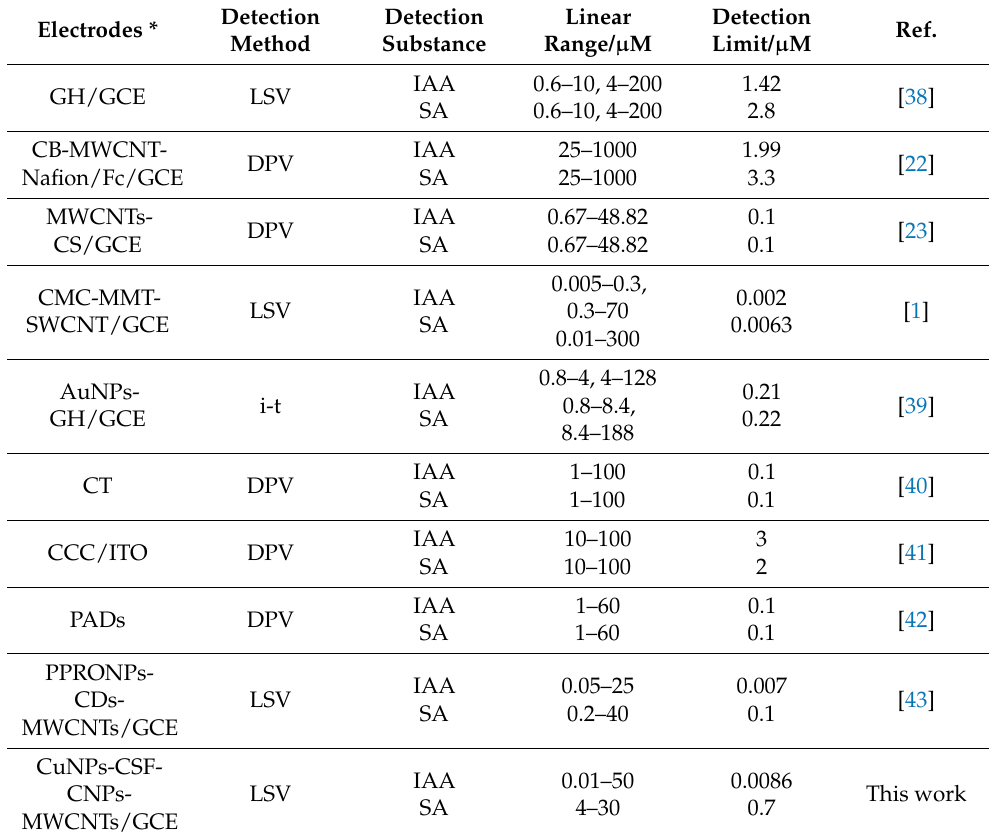
Table 2. Comparison of some typical modified electrodes for determination of IAA and SA. Electrodes